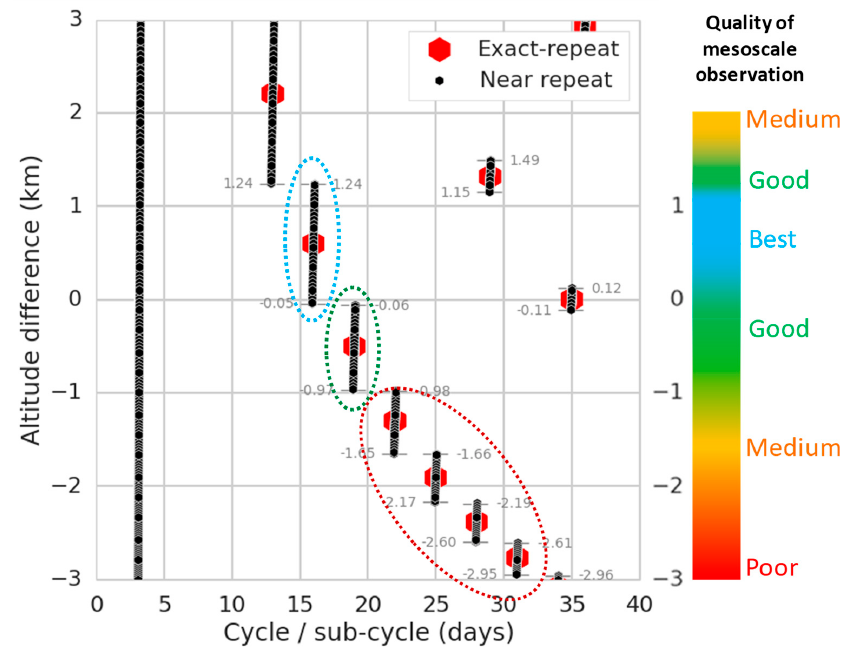
Figure 5. Overview of the dominant sub-cycles for a 6-km altitude range near the historical ERS orbit. The quality of mesoscale observation is controlled by some sub-cycles (15 to 19 days is better as shown in Figure 3) so some altitude ranges are better than others (colored ellipses and right-hand-side color bar).